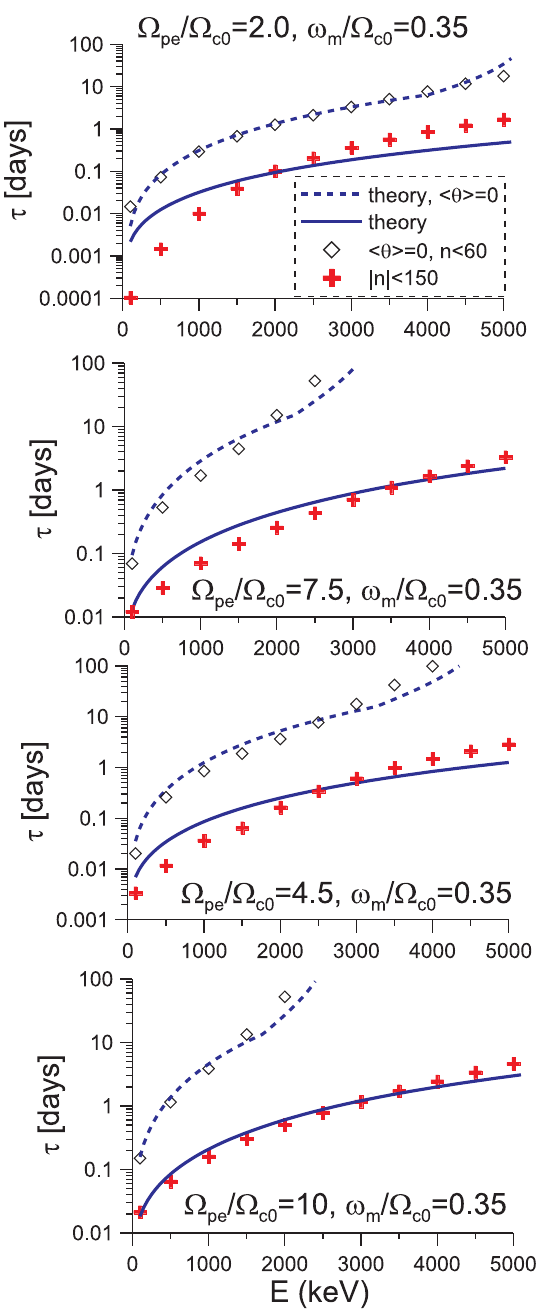
Fig. 13. Electron lifetimes for four values of the ratio (cid:127) pe /(cid:127) c0 , for quasi-parallel and oblique chorus waves. Full numerical solutions as well as the corresponding analytical estimates in Eqs. (9) and (12) are displayed.